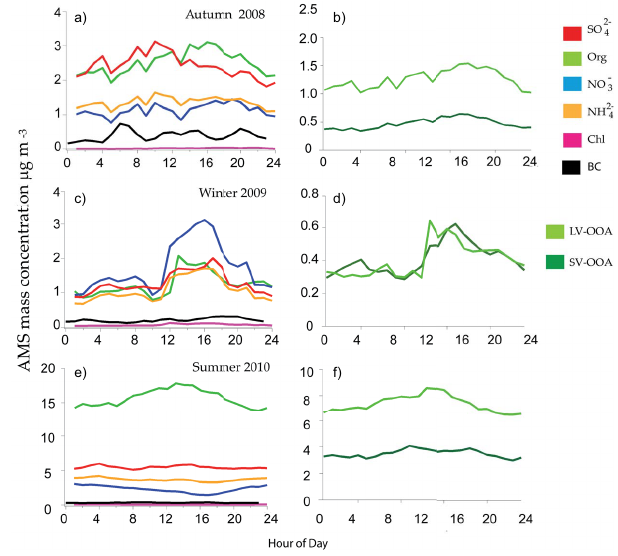
Fig. 6. Diurnal variation of mass concentration of BC and inorganic and organic particles for autumn, (a) and (b) , winter, (c) and (d) , and summer, (e) and (f)